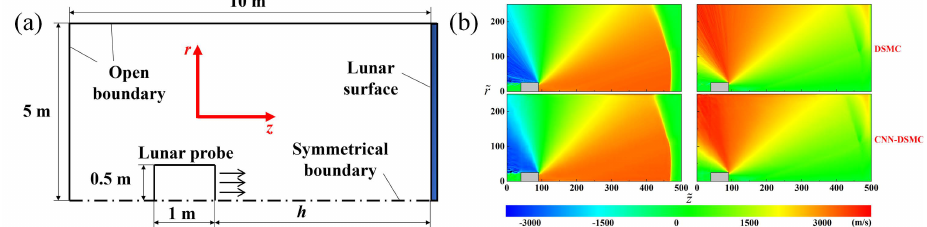
Figure 20. ( a ) Schematic of computational domain and boundary conditions of the two-dimensional axisymmetric case. ( b ) The axial (left) and radial (right) velocities at the altitude of h = 8.2 m obtained by the DSMC and CNN-DSMC